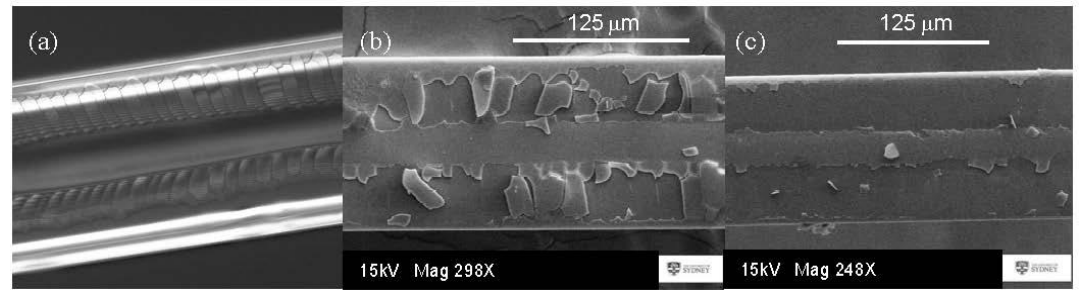
Figure 2. Horizontal “dip-and-withdraw” deposition of nanoparticle layers (stage v = 0.1 mm/s, t = 5 min; [SiO ] = 5 wt%). ( a ) Optical microscope image showing film formation stat 2 nano